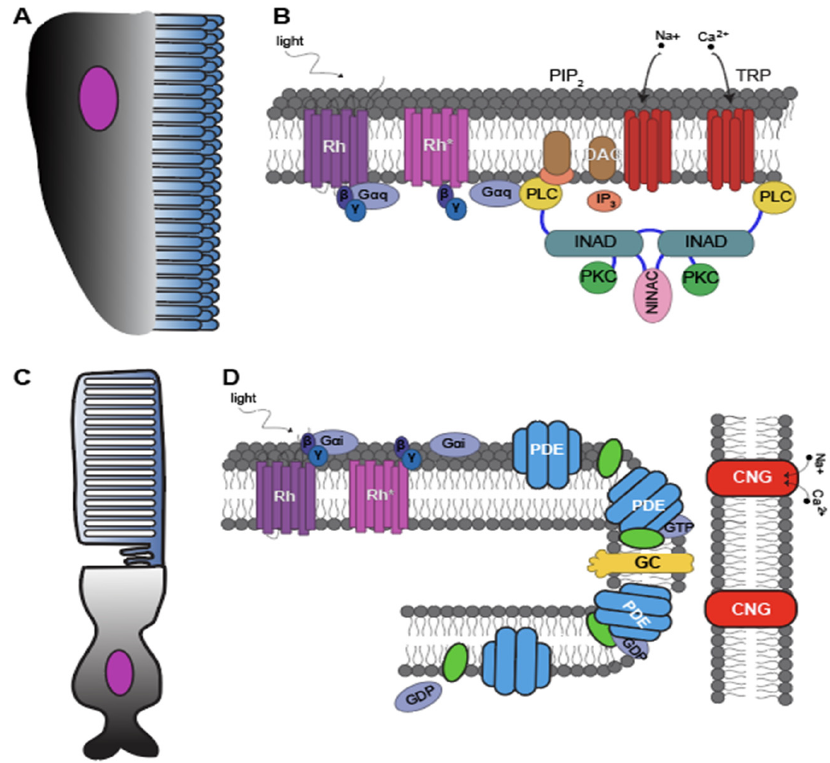
Figure 2. Schematic of rhabdomeric and ciliary receptors and cascades. ( A ) Drawing of a rhabdomeric photoreceptor cell. ( B ) Model of the phototransduction cascade in Drosophila . ( C ) Drawing of a ciliary rod photoreceptor. ( D ) Model of the phototransduction cascade in vertebrates. Figure adapted from Fain et al., 2010 [12].